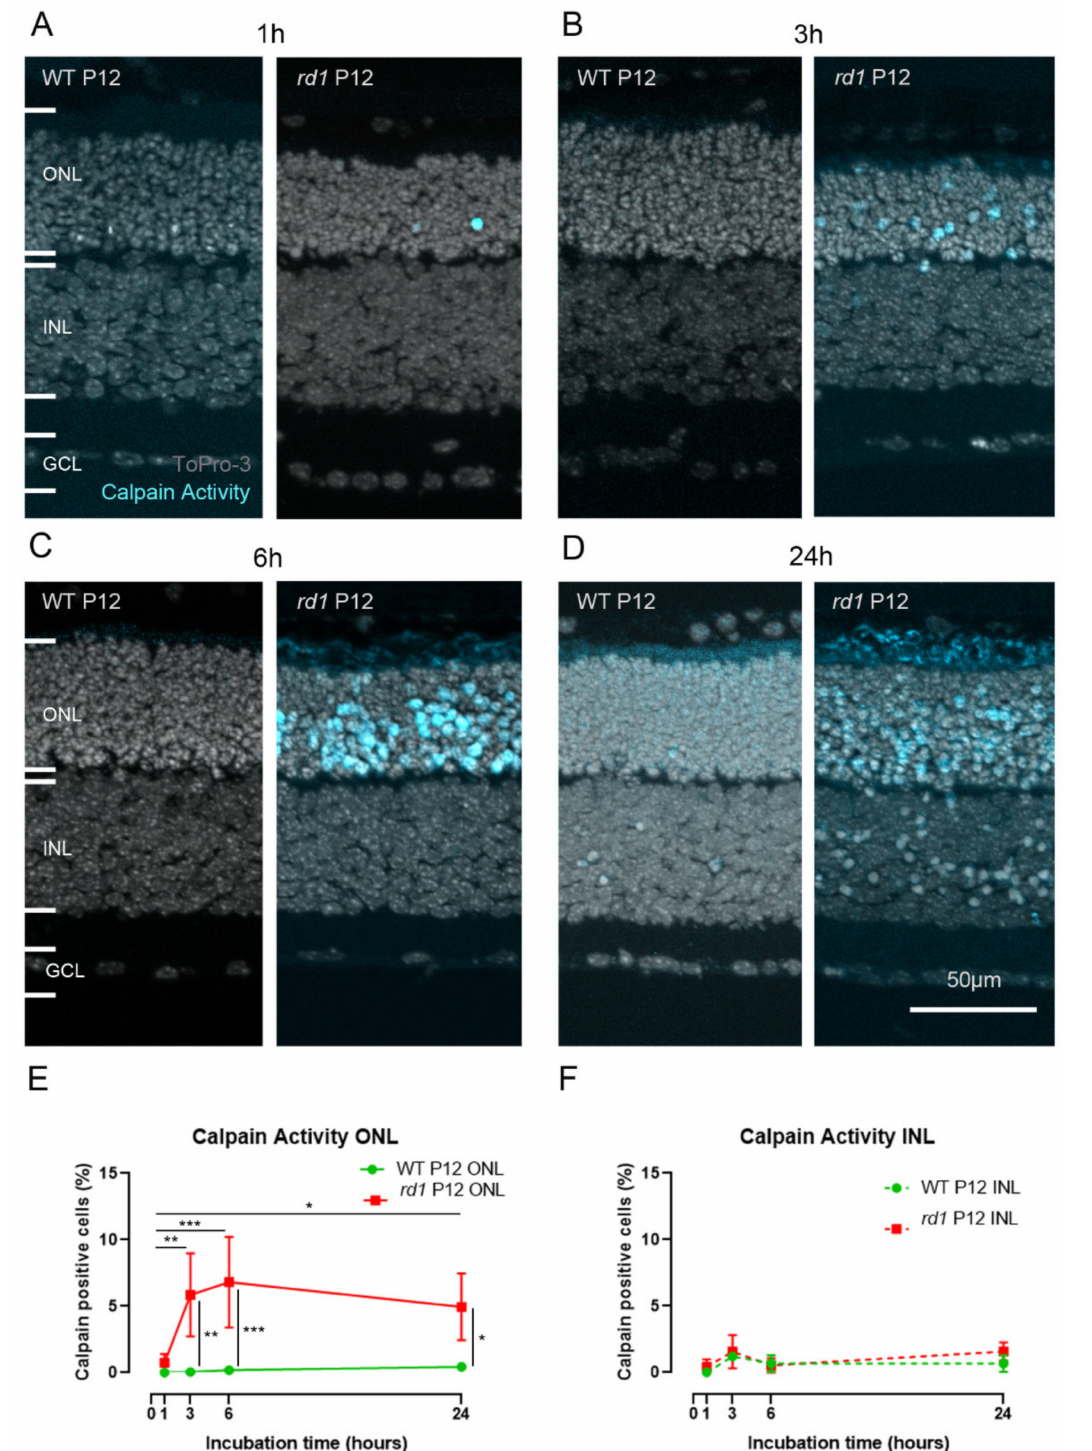
Figure 2. Live tissue detection of calpain activity in the rd1 mouse model. Organotypic retinal explant cultures were incubated with 50 µ M CMAC for 1 h ( A ), 3 h ( B ), 6 h ( C ), or 24 h ( D ) before the culture was ended by fixation. To-Pro-3 was used as nuclear counterstain. The number of calpain- positive cells detected in the rd1 outer nuclear layer (ONL) increased from 1 h to 6 h to reach a plateau by 24 h ( E ), whereas in the inner nuclear layer (INL), no specific trend was observed ( F ). Images representative of results obtained from six to nine independent retinal explant cultures; error bars indicate STD; statistical analysis: two-way ANOVA with Holm–Sidak’s multiple comparisons test; * = p < 0.05; ** = p < 0.01; *** = p < 0.001; GCL = ganglion cell